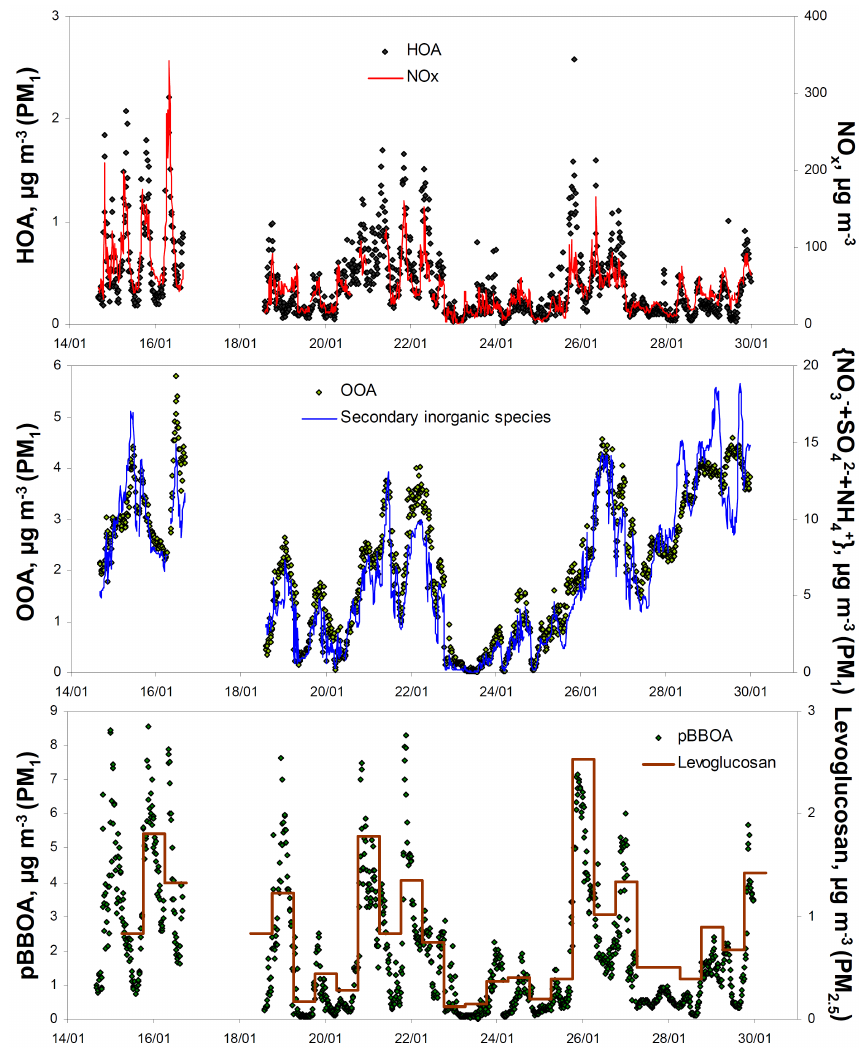
Fig. 6. Time series of each PMF factor (3-factorial PMF, “FPEAK” = − 0.2 and “seed” = 0) along with some of their corresponding Figure 6